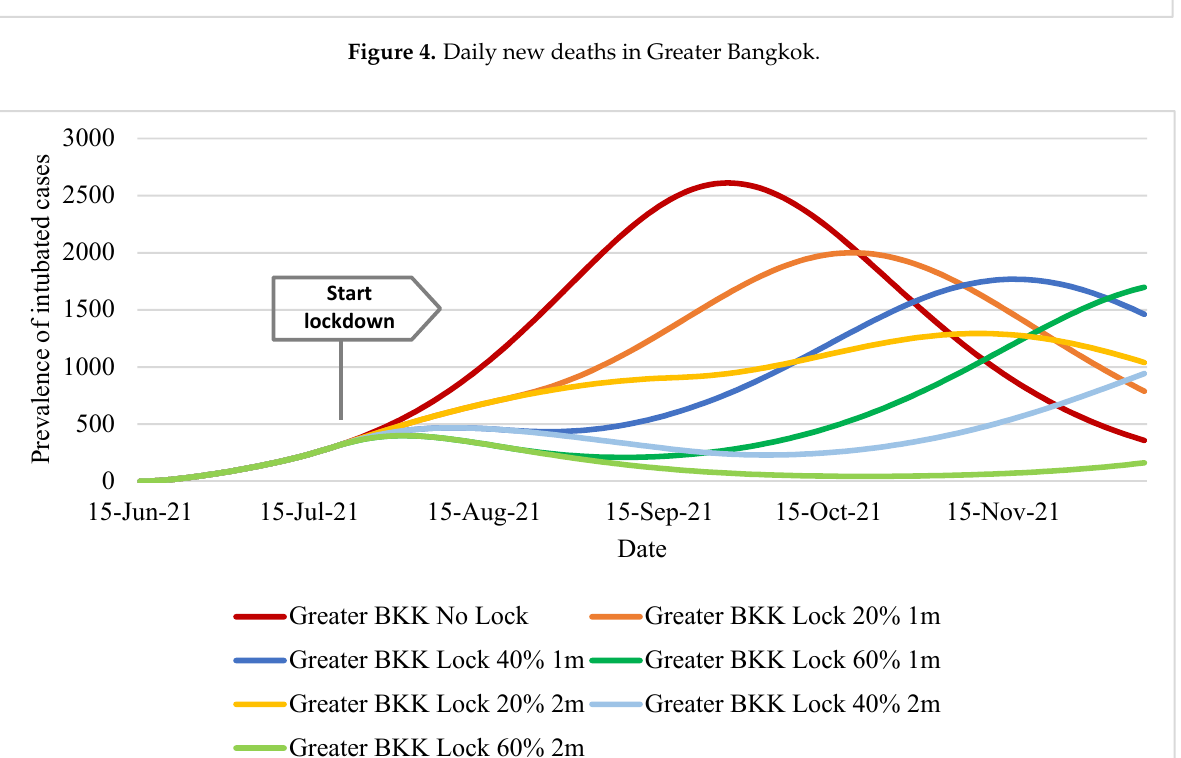
Figure 4. Daily new deaths in Greater Bangkok.